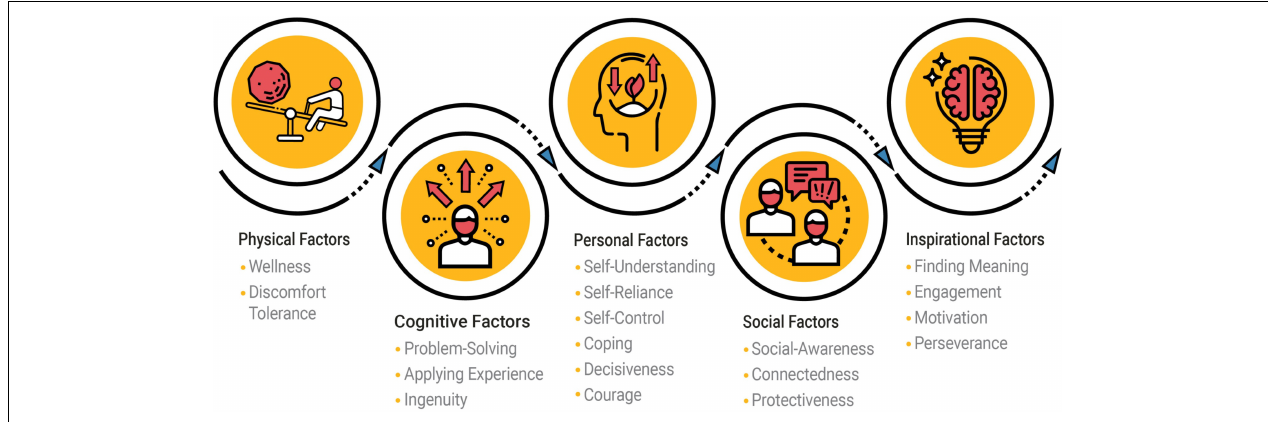
FIGURE 1 | Conceptual presentation of the MMP model, supported by principal components. © 2021 Into Performance ULC. All Rights